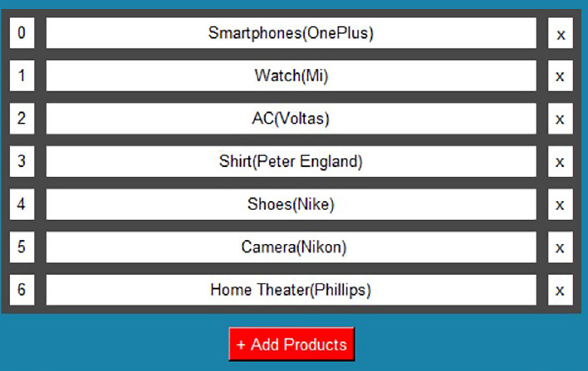
Fig. 5. Products Added by